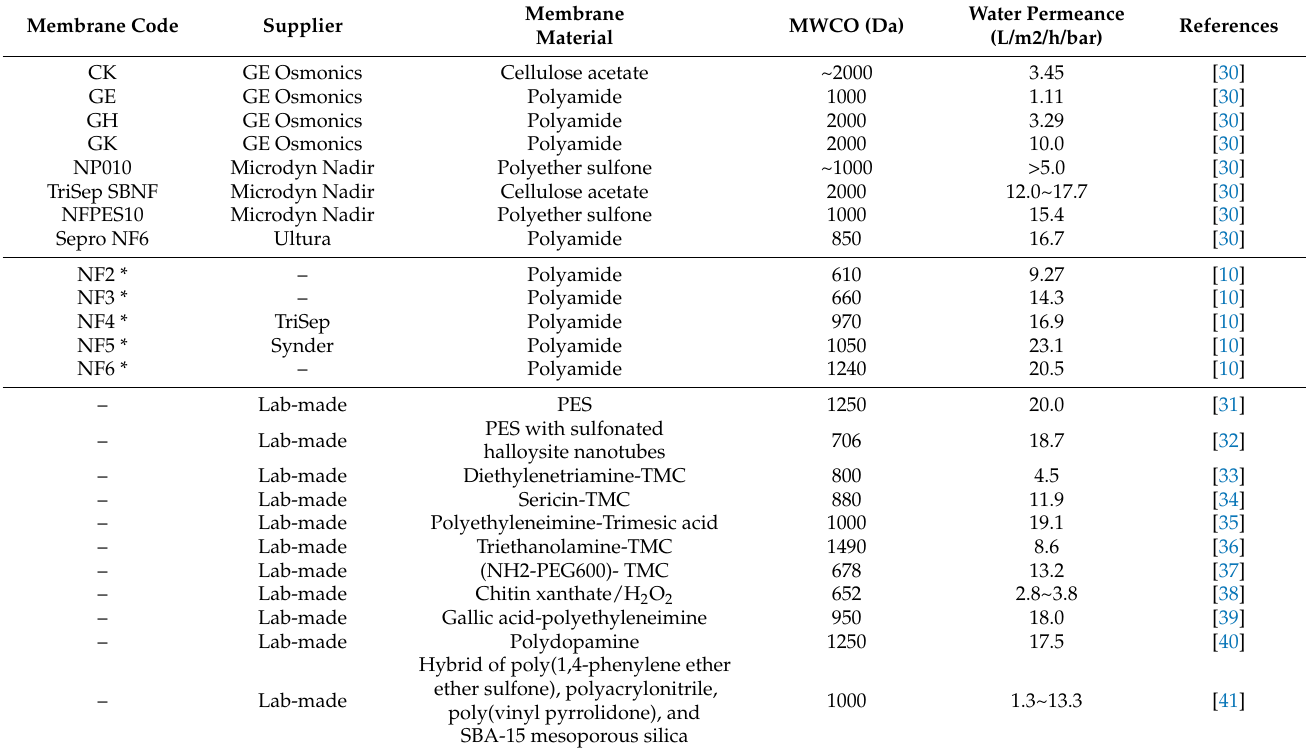
Table 2. Main information of commercially available LNF